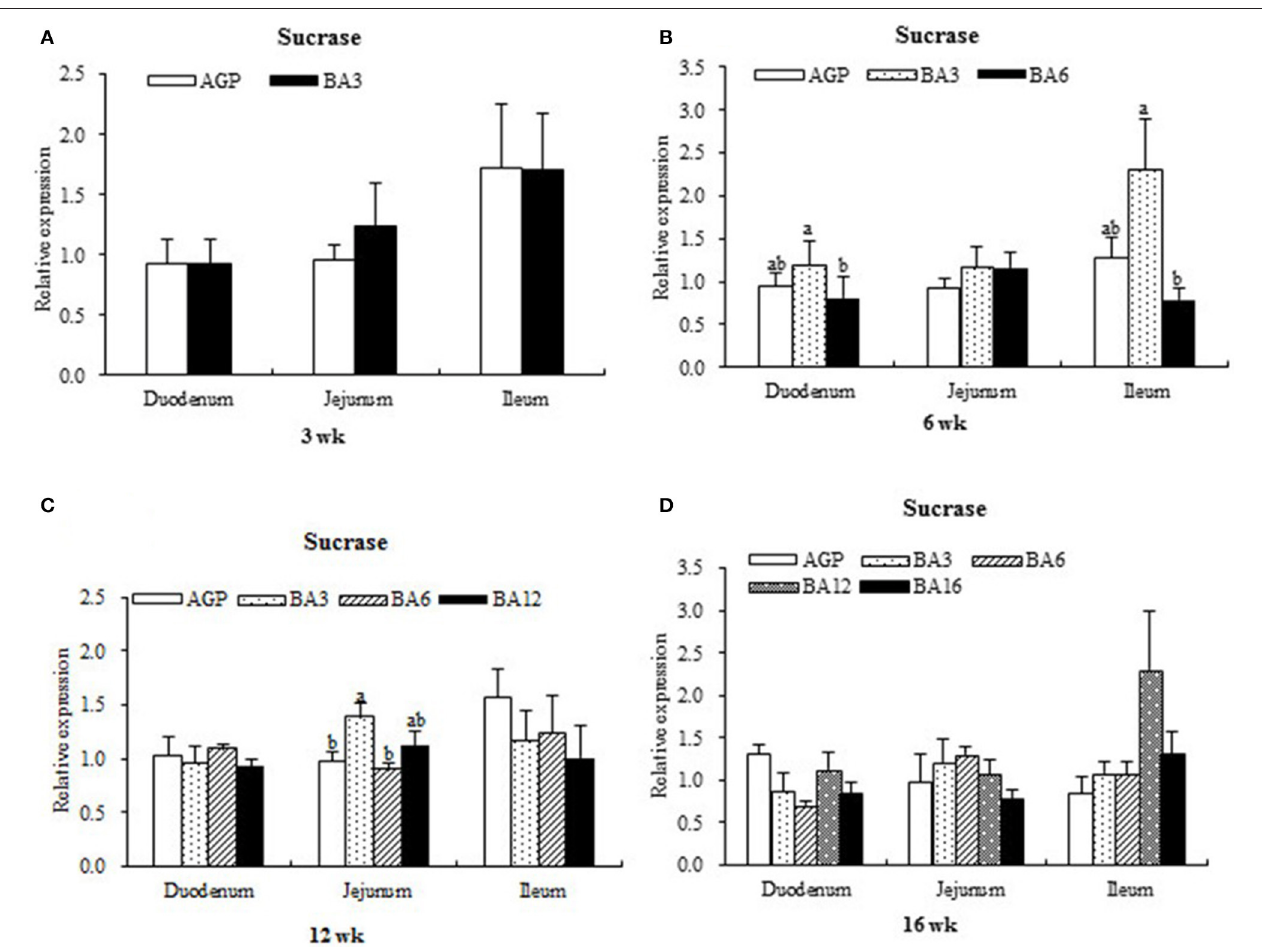
FIGURE 1 | Transcript level of sucrase in the intestinal mucosa of pullets in 0 ∼ 16 weeks. The intestinal positions include duodenum, jejunum, and ileum. (A) Relative expression of sucrase at week 3. (B) Relative expression of sucrase at week 6. (C) Relative expression of sucrase at week 12. (D) Relative expression of sucrase at week